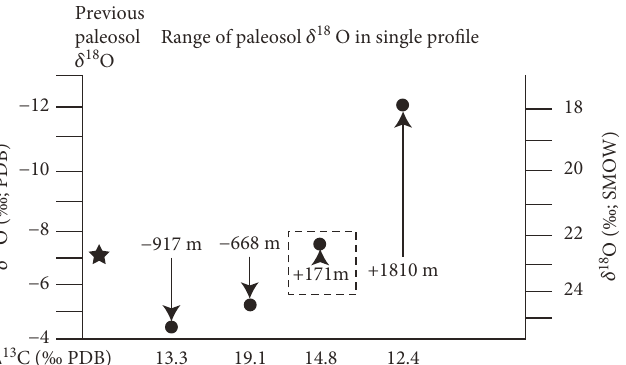
Figure 2: Plot of δ 18 O data from a single paleosol horizon from the early Eocene Wasatch Formation (Wyoming, USA). Theoretical uplift carb or denudation estimates for individual paleosols along the transect based upon the global δ 18 O lapse rate of Poage and Chamberlain [18]. The samples outlined by the dashed box is the only one that is in C isotope equilibrium (see text for